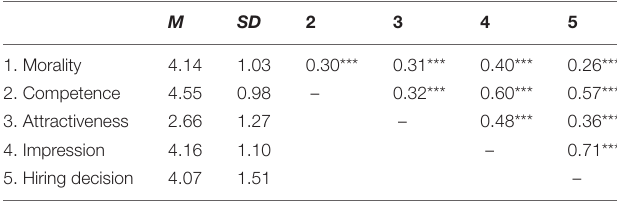
TABLE 2 | Means, standard deviations, and correlations among all study